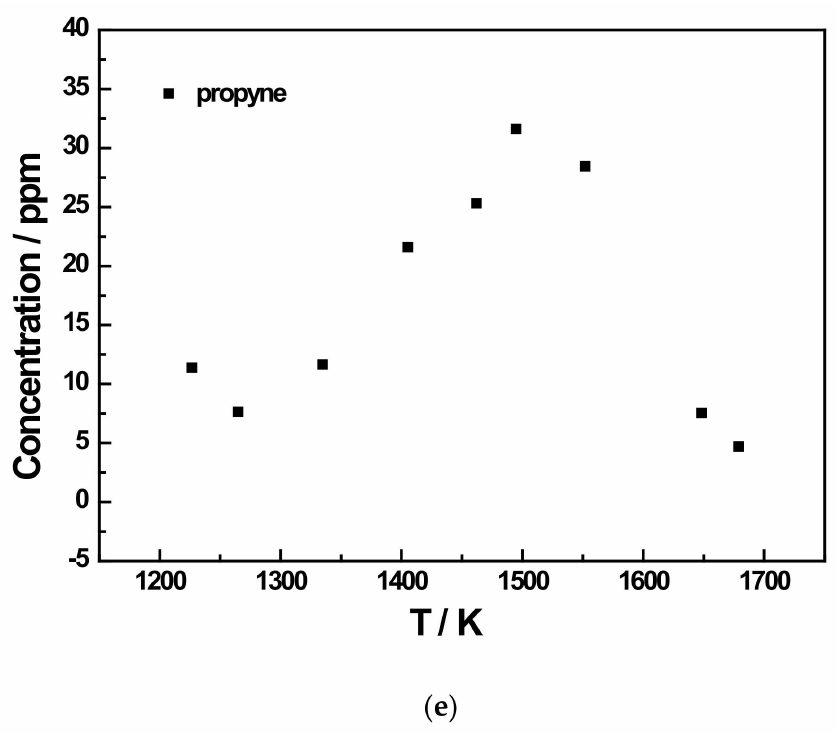
Figure 6. Species profiles as a function of temperature for the 200 ppm JP-10 pyrolysis experiment at 5 bar. ( a ) Methane and ethene concentration profiles of 200 ppm JP-10 (in Ar) pyrolysis; ( b ) Acetylene concentration profile of 200 ppm JP-10 (in Ar) pyrolysis; ( c ) Ethane and propene concentration profiles of 200 ppm JP-10 (in Ar) pyrolysis; ( d ) Allene and 1,3-butadiene concentration profiles of 200 ppm JP-10 (in Ar) pyrolysis; ( e ) Propyne concentration profiles of 200 ppm JP-10 (in Ar)